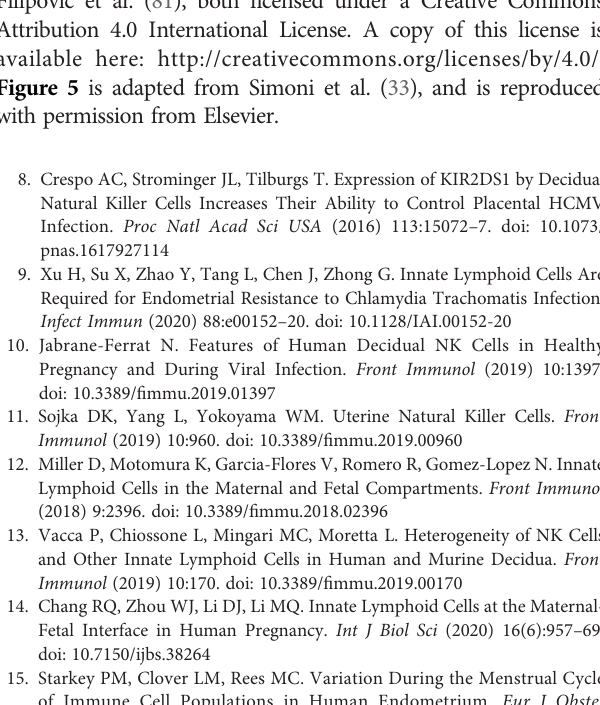
Figure 5 is adapted from Simoni et al. (33), and is reproduced with permission from